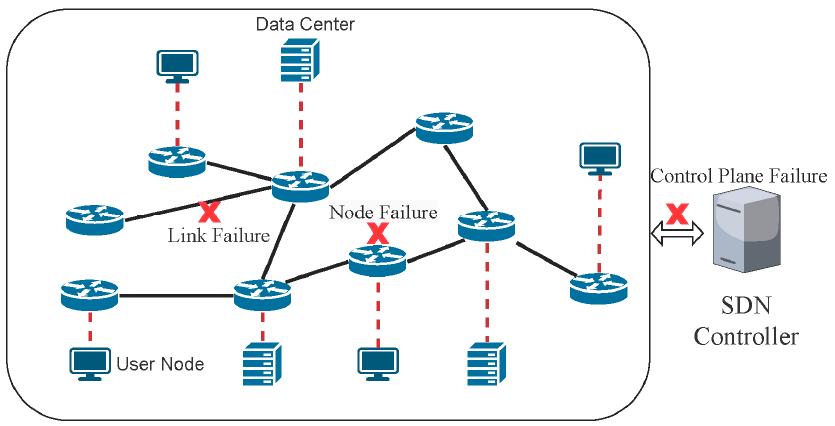
Figure 2. SRC model.